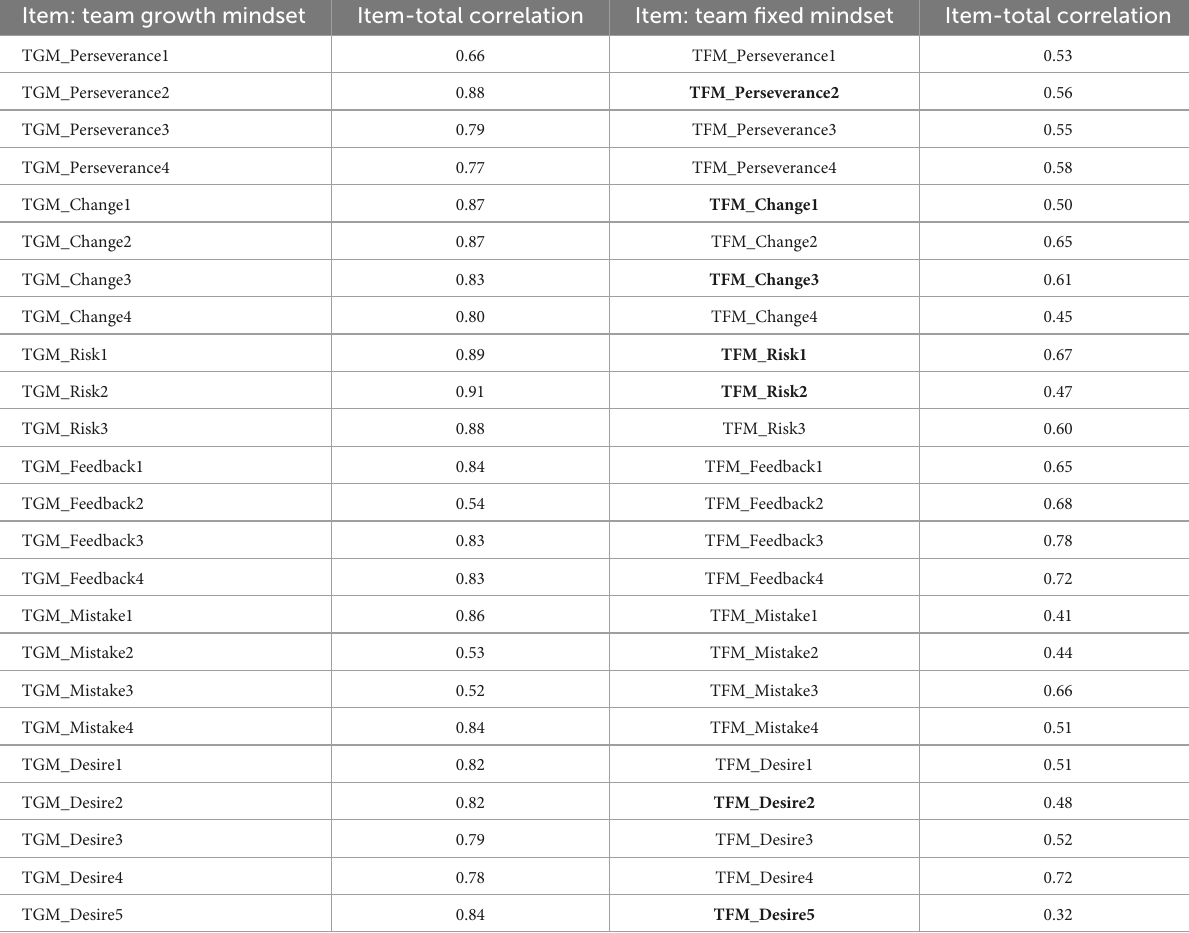
TABLE 2 Item analysis of team growth and fixed mindset in classical test theory